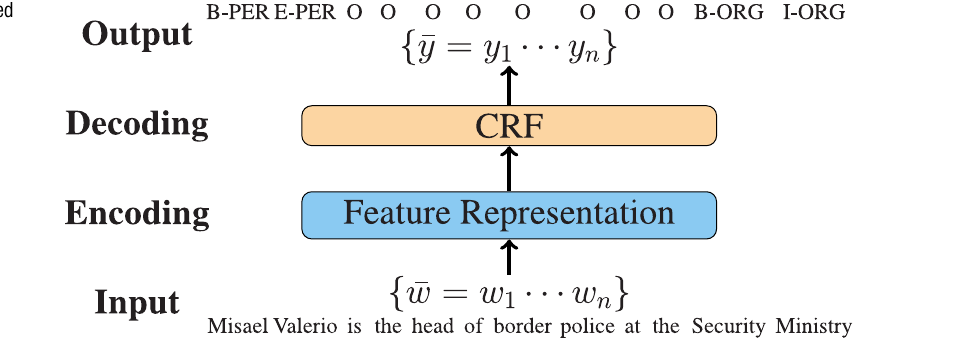
Fig 1. An example of neural NER with sequence